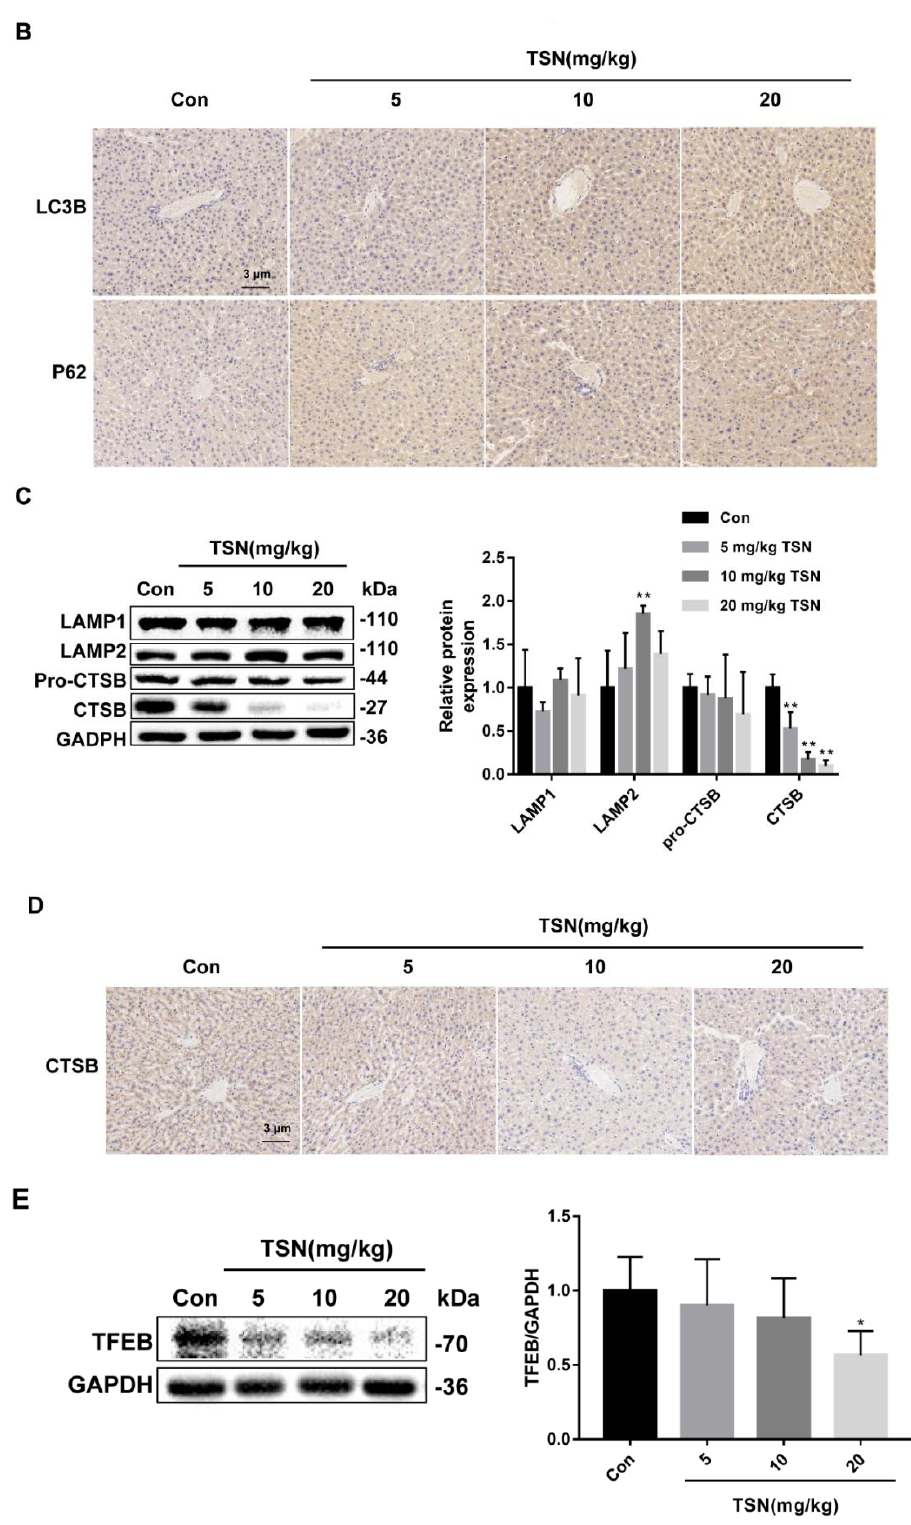
Figure 8. TSN inhibited autophagic flux and induced lysosome dysfunction in Balb/c mice. Balb/c mice were intraperitoneally administered TSN at different doses (5, 10, 20 mg/kg) or by vehicle for 24 h. Serum and liver tissue were harvested after TSN treatment. ( A ) The protein levels of LC3B and P62 were determined by Western blotting, and the ratios of LC3B- Ⅱ /GAPDH and P62/GAPDH were calculated using ImageJ software. ( B ) Representative results of IHC staining for LC3B and P62. Scale bar: 3 μm. ( C ) The protein levels of LAMP1, LAMP2, and CTSB were determined by Western blotting, and the ratios of LAMP1/GAPDH, LAMP2/GAPDH, and CTSB/GAPDH were calculated using ImageJ software. ( D ) Representative results of IHC staining for CTSB. Scale bar: 3 μm. ( E ) The protein level of TFEB was determined by Western blotting. Data are presented as the mean ± SD * p < 0.05, ** p < 0.01 versus vehicle, n = 9.